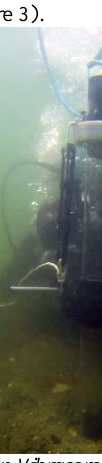
Figure 1. Core sampler. Vibracorer head uppermost with lead weight around the plastic coring tube to aid penetration of the seabed.